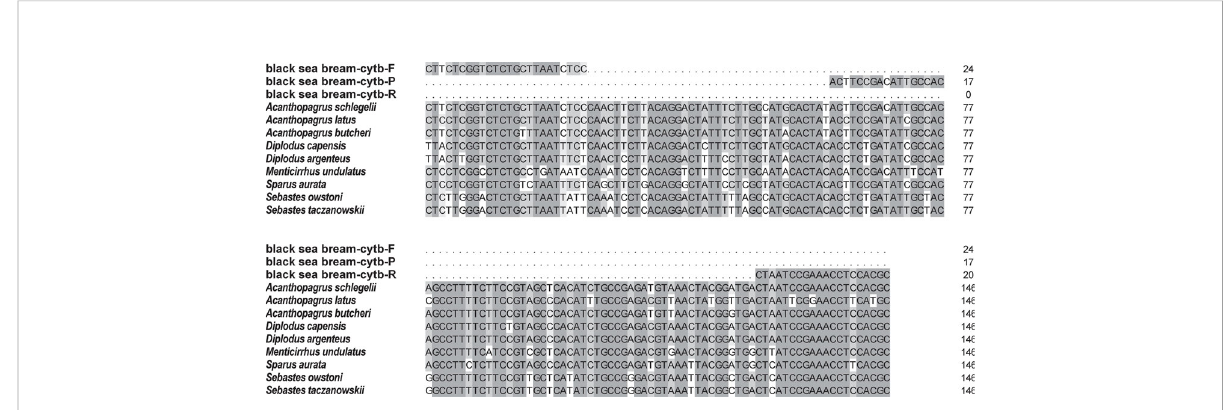
FIGURE 2 Sequences of designed black sea bream-speci fi c primers and probe and the results of comparison with other closely related